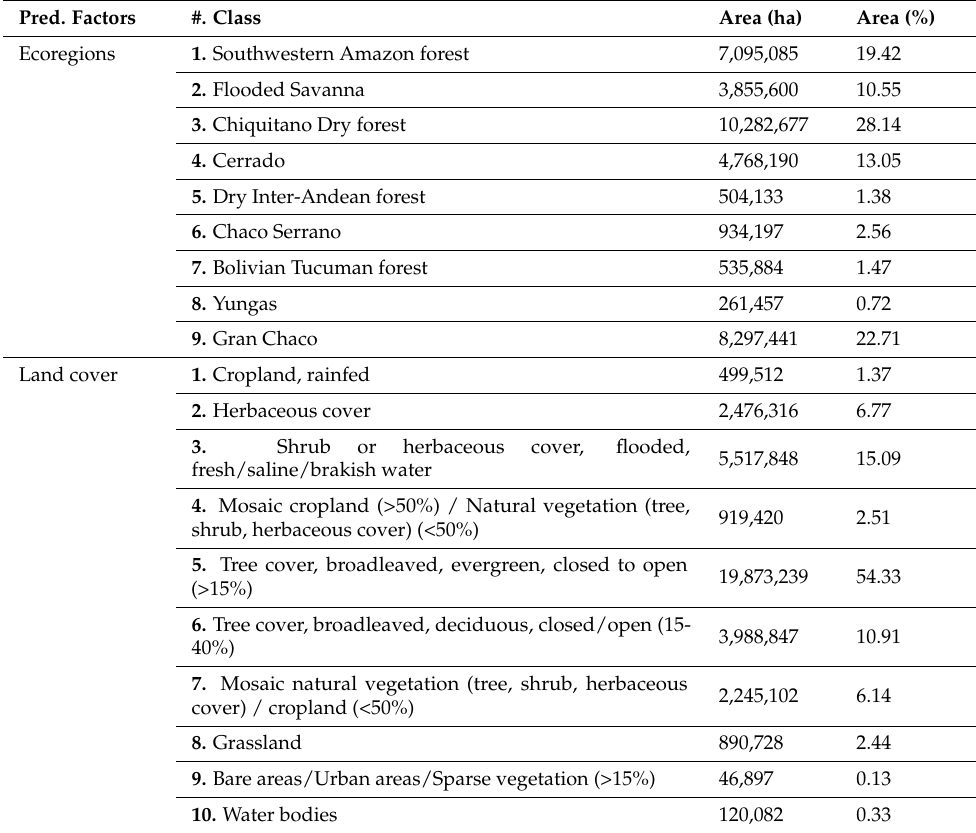
Table 2. Ecological, land cover, and vegetation